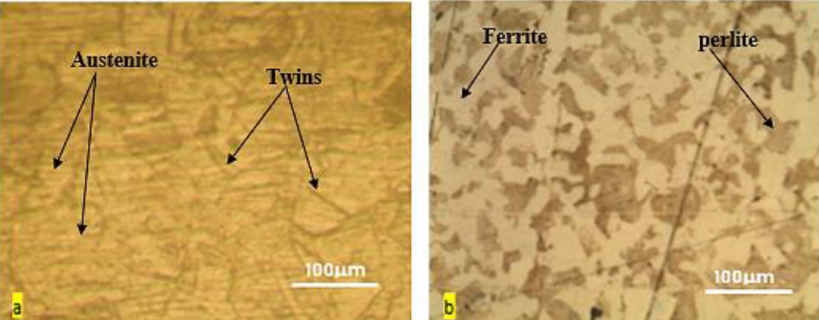
Figure 13. Microstructure of base metals: ( a ) 316 stainless steels; ( b ) AISI